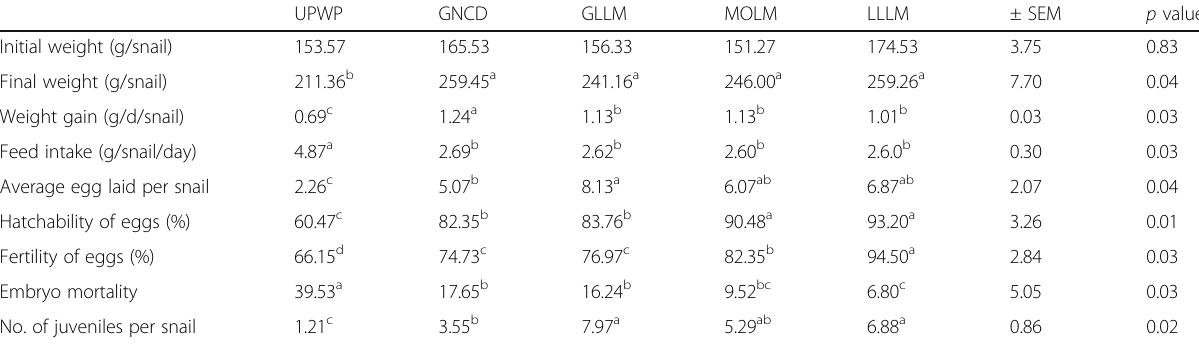
Table 2 Reproductive performance of laying snails fed with roughages and concentrate with different leaf proteins UPWP GNCD GLLM MOLM LLLM ± SEM p